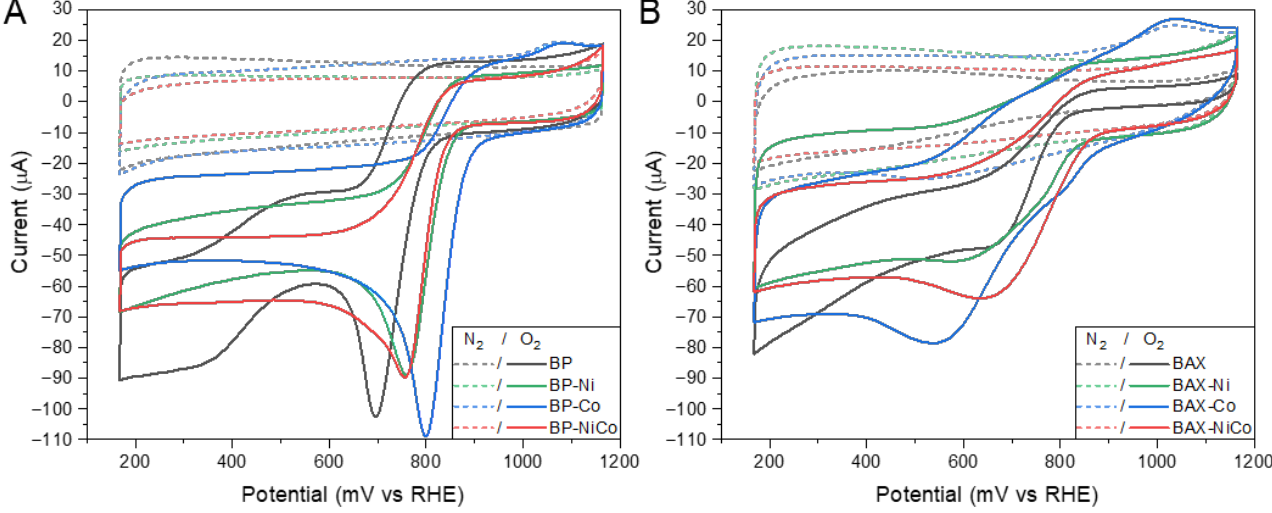
Figure 1. CV curves in oxygen and nitrogen saturated electrolytes for the BP ( A ) and BAX ( B ) series. As expected, LSV curves (Figure S1 of the Supplementary Information) show that the current depends on a rotation rate, especially for the BP series, which is typical for a